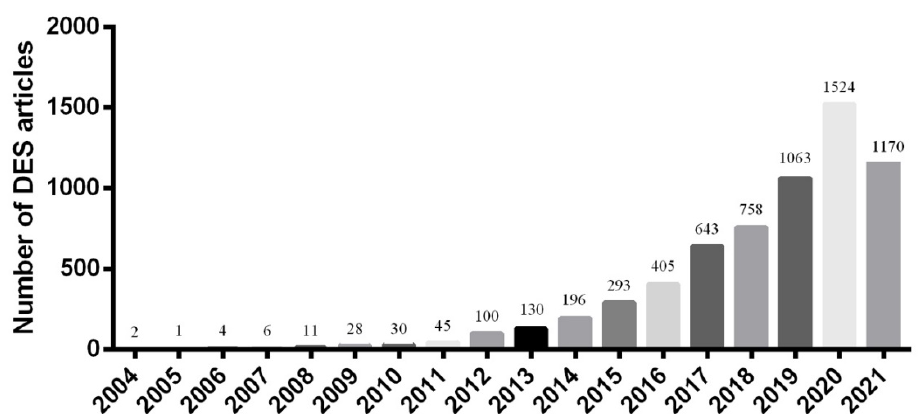
Figure 1. Evolution of the number of manuscripts about DESs in the period 2004–2021 (September). Source: Web of Science.